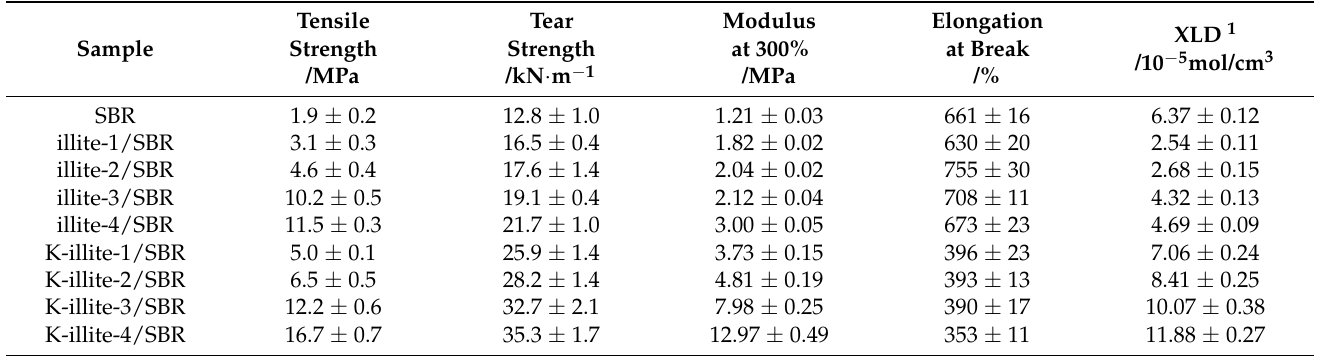
Figure 2. Mechanical properties of illite/SBR and K-illite/SBR vulcanizates filled with different particle sizes of filler. ( a ) tensile strength, ( b ) tear strength, ( c ) modulus at 300%, ( d ) elongation at break. Table 3. Mechanical properties and crosslinking density of different vulcanizates.